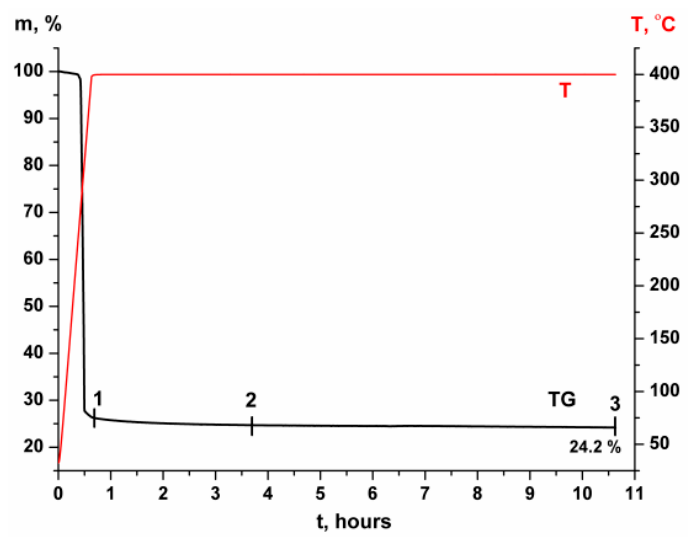
Figure 6. Curves of thermal analysis in reductive atmosphere (7.2% H 2 /He) for complex 2 . Points 1, 2 and 3 on the TG curve correspond to an annealing time of zero, three and ten hours.